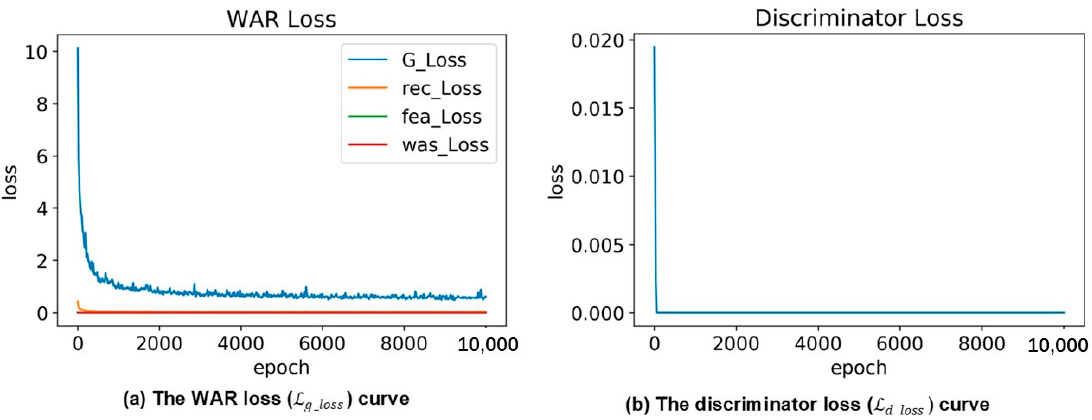
Figure 8. The ( a ) WAR loss ( ℒ g _ loss ) and ( b ) discriminator loss ( ℒ d _ loss ) curve of the proposed WAR model with